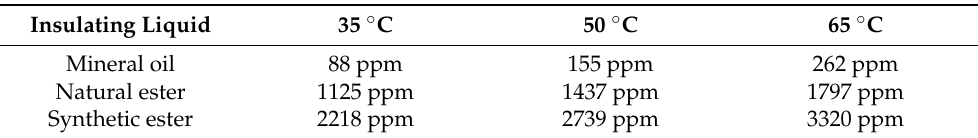
Figure 7. Relative saturation of water in synthetic ester during its drying with a 3A molecular sieve. Table 3. Limits for the solubility of water in mineral oil, natural ester, and synthetic ester at 35 ◦ C, 50 ◦ C, and 65 ◦ C